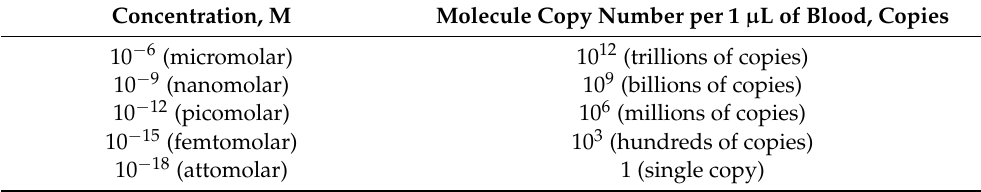
Table 1. Number of biomolecules in blood at different